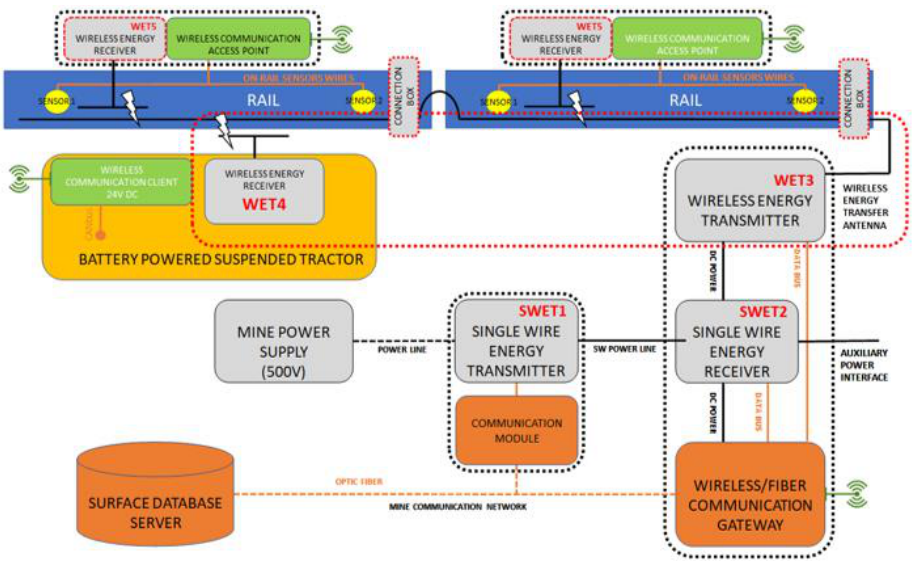
Figure 3. Concept for an innovative power supply system being developed within the HEET II pro- ject [16].